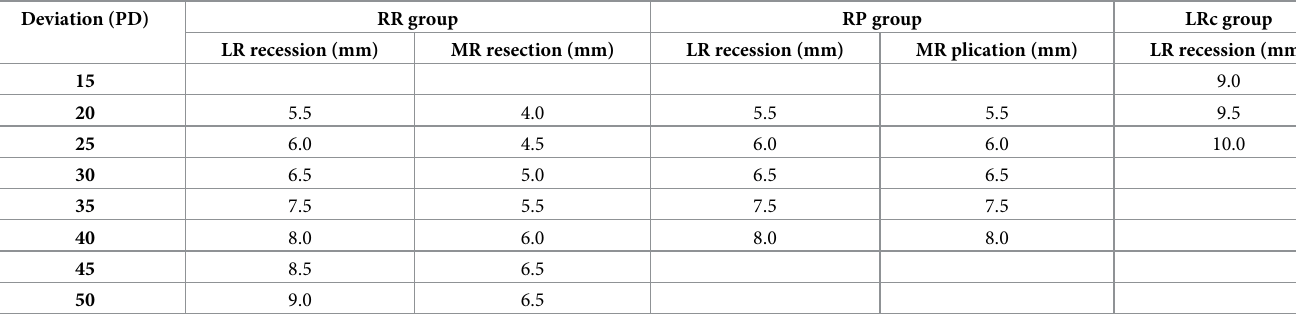
Table 1. Surgical table in children with intermittent exotropia.